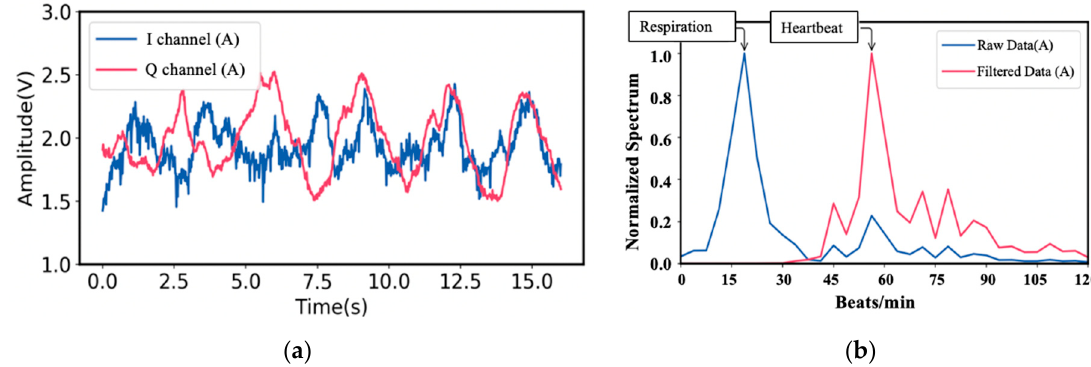
Figure 8. ( a ) Time domain vital sign signal of Target A; ( b ) the measured respiration and heartbeat rates of Target A using MTM LWA-based homodyne radar sensor module band [49].